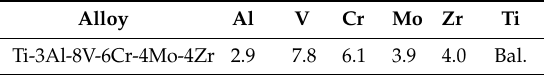
Table 1. Chemical composition of alloys